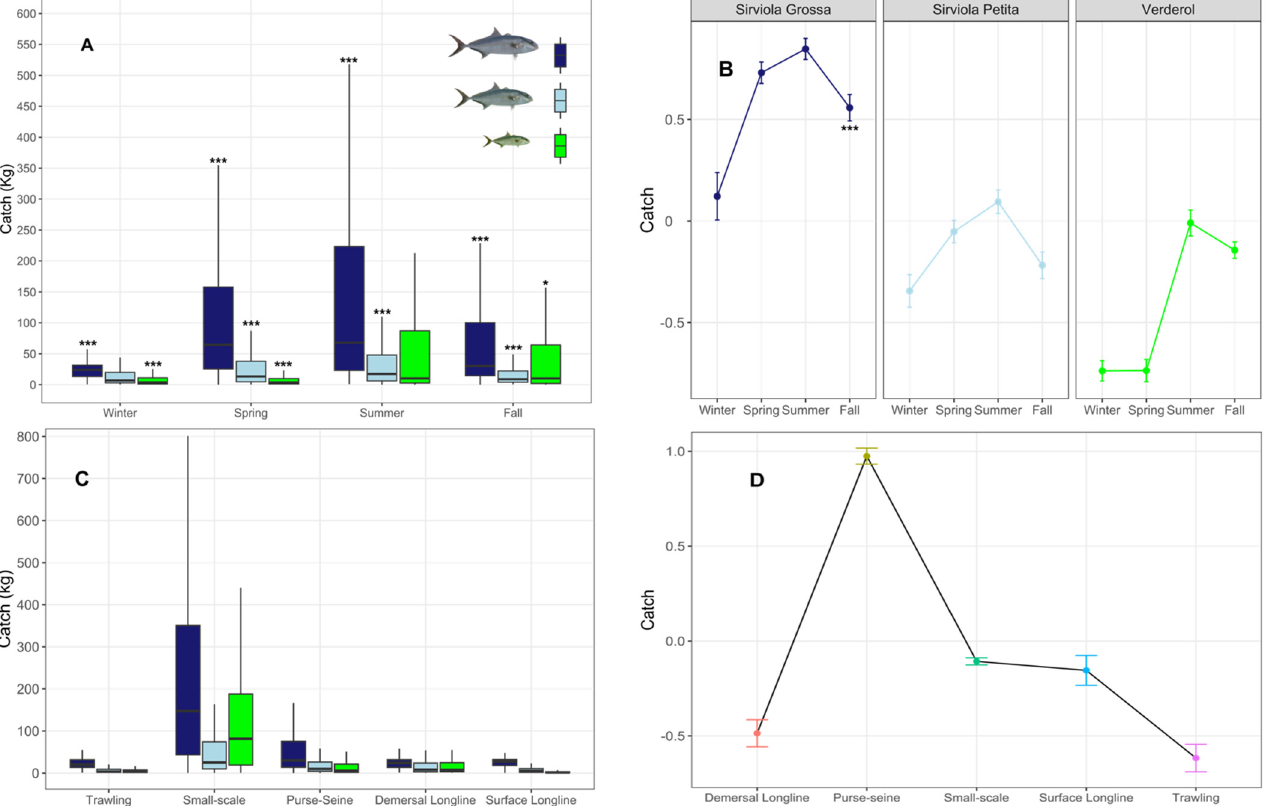
Figure 4. ( A ) Seasonal distribution of daily catches of the different size classes (asterisks above boxes indicates p -values * < 0.05 and *** < 0.001). ( B ) Partial effects of the interaction between Categories and Season on S. dumerili catches. ( C ) Proportion of S. dumerili landings (kg) for each Gear investigated with correspondent partial gear effect plot ( D ).